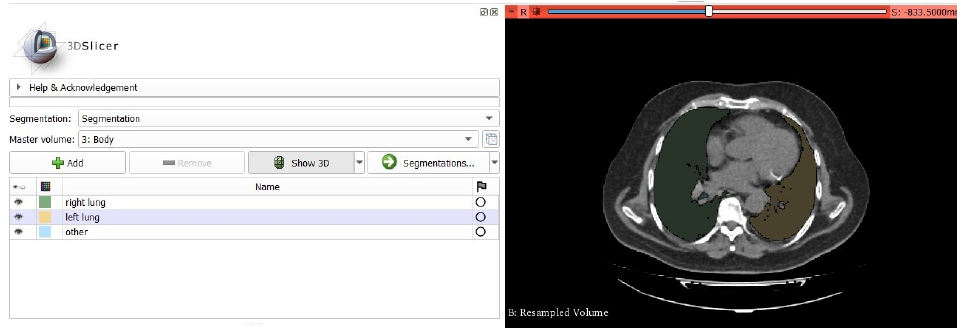
Figure 2. The 3DSlicer manual tool ( “Segment Editor” ) accomplished the unsatisfactory segmentation. In this section, the user can perform a manual segmentation using the colors listed on the left board.